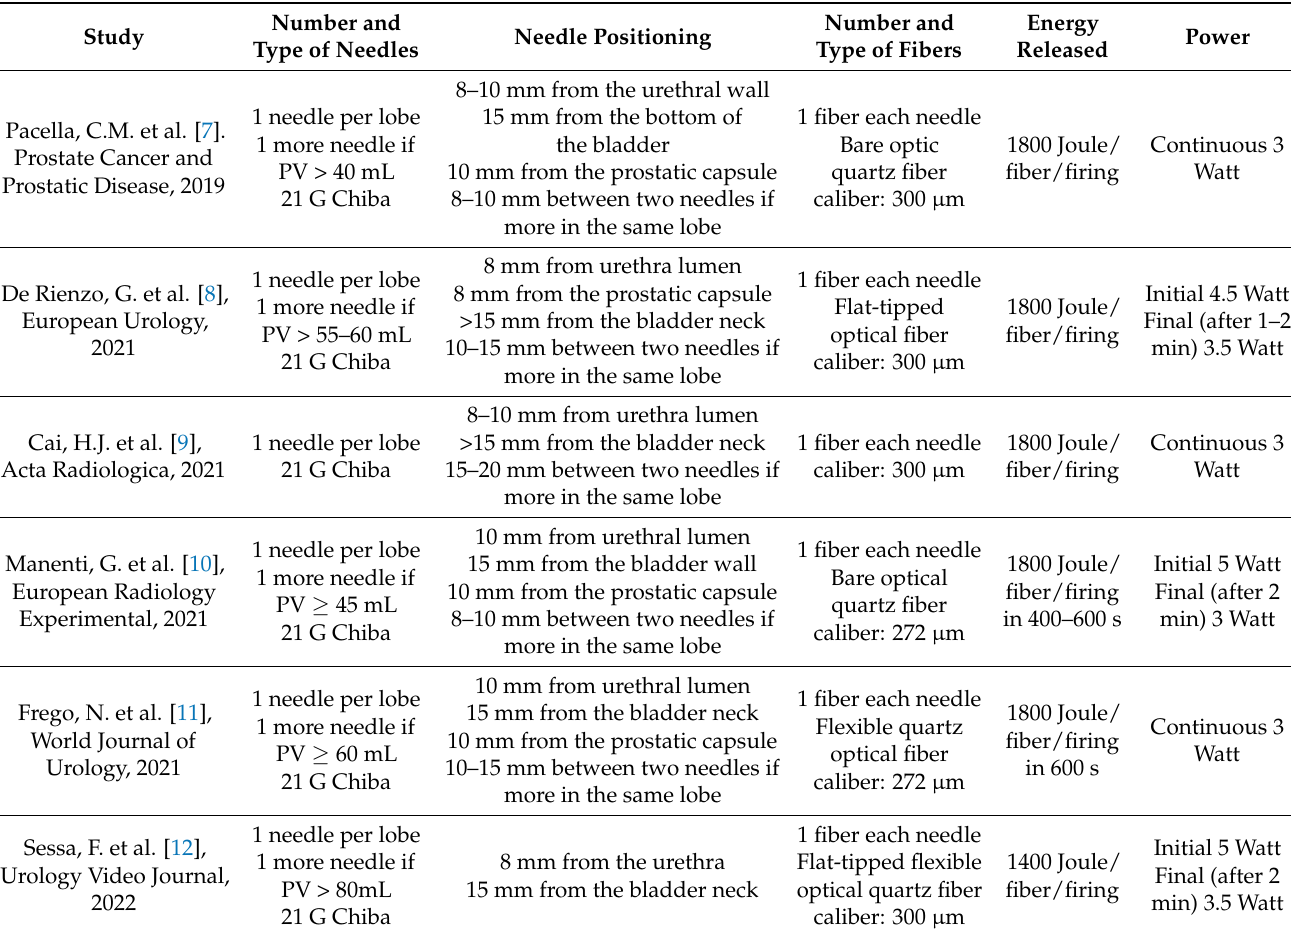
Table 2. Technical aspects of transperineal laser ablation (TPLA) procedure for benign prostatic enlargement (BPE) in the six included